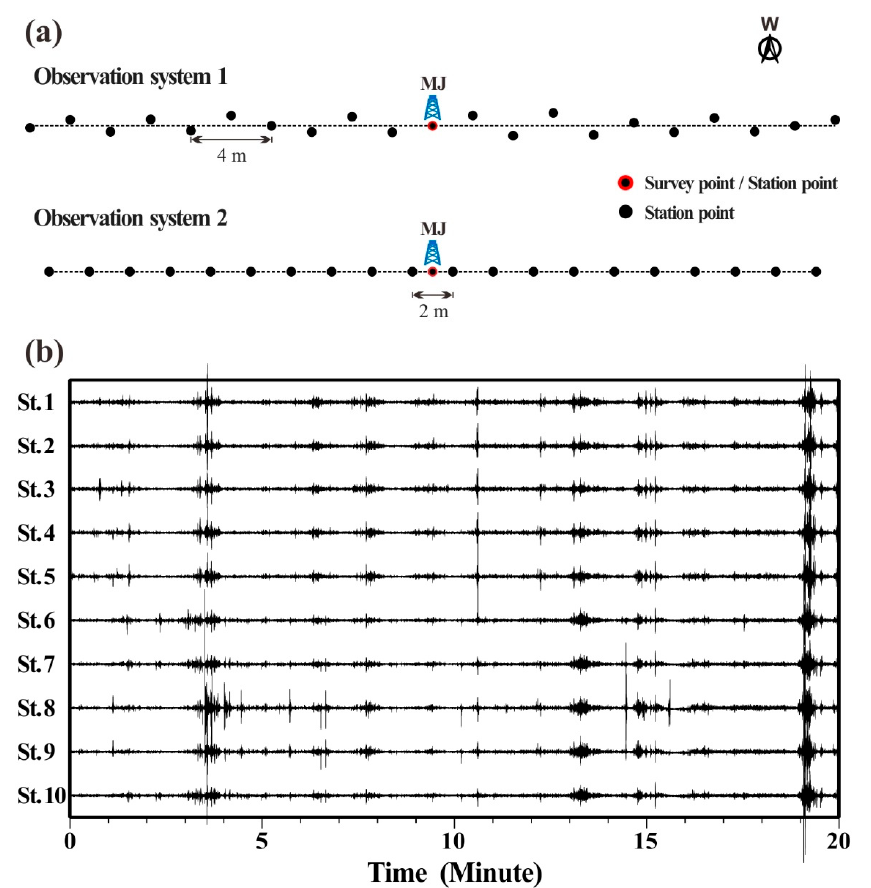
Figure 8. Waveform of observation array and part of measured microtremor signals. ( a ) Schematic diagram of observation array; ( b ) waveforms of microtremor signals at part of observation stations.